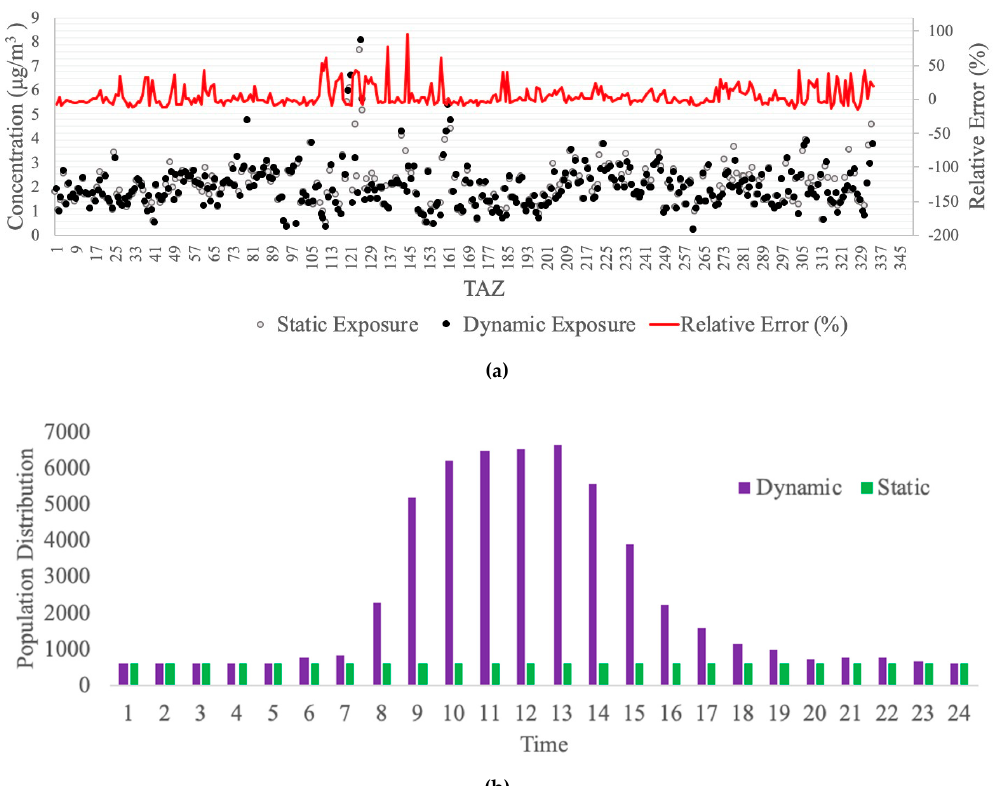
Figure 6. Comparison between dynamic and static estimation. ( a ) Comparison of population-weighted concentration (all TAZs), ( b ) Comparison of population distribution (TAZ 144).